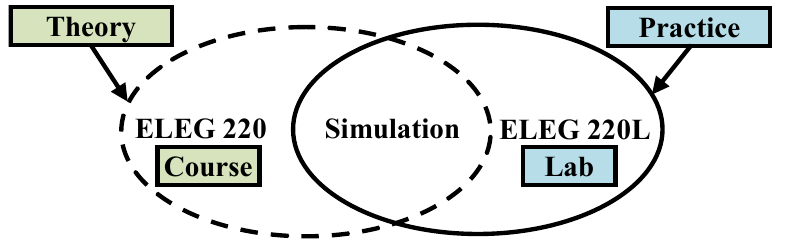
Fig. 2. Layout of the course ELEG 220, and its concurrent lab, ELEG